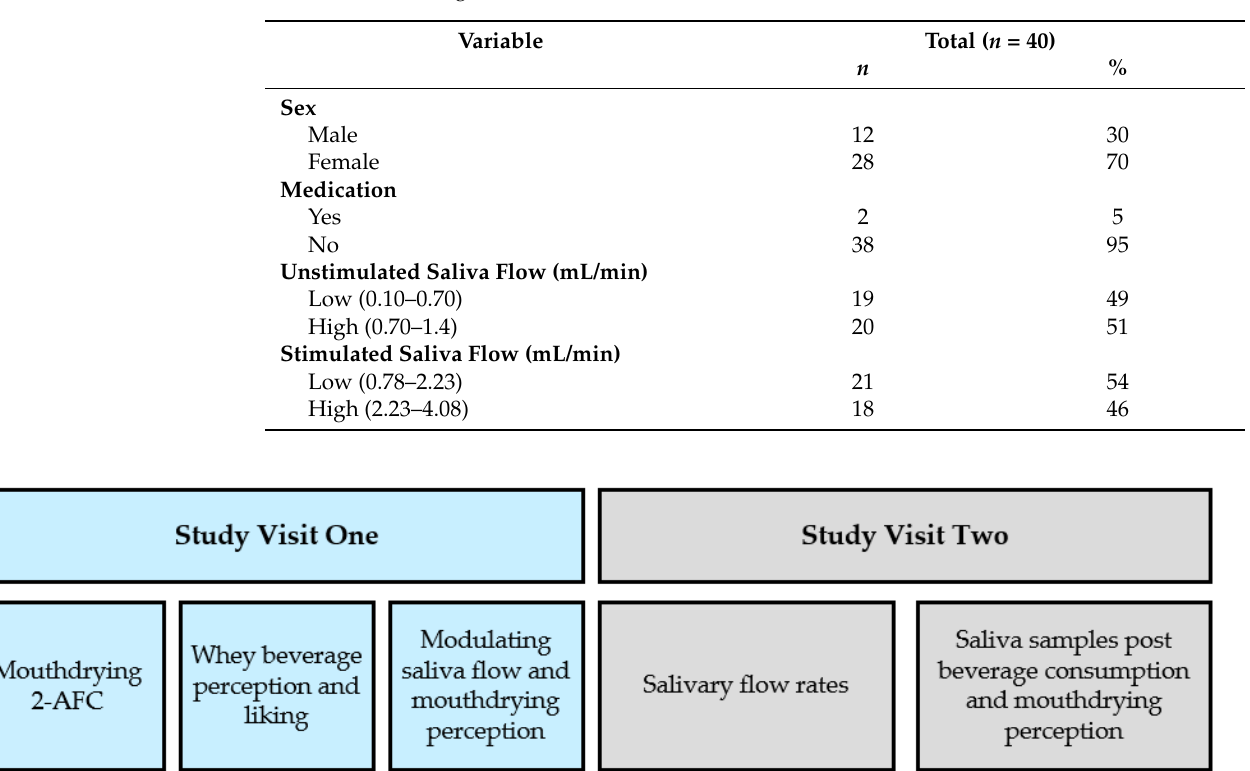
Table 1. Summary of volunteers’ sex, medication and salivary flow rates categories (‘ n ’ and ‘%’ indicate number and percentage). Saliva flow categories were defined as below (or equal to) or above the median (missing data n = 1).